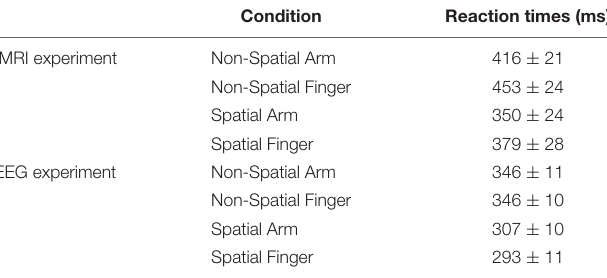
TABLE 1 | Mean reaction times in each condition for the fMRI and electroencephalography (EEG) experiments. Condition Reaction times (ms) fMRI